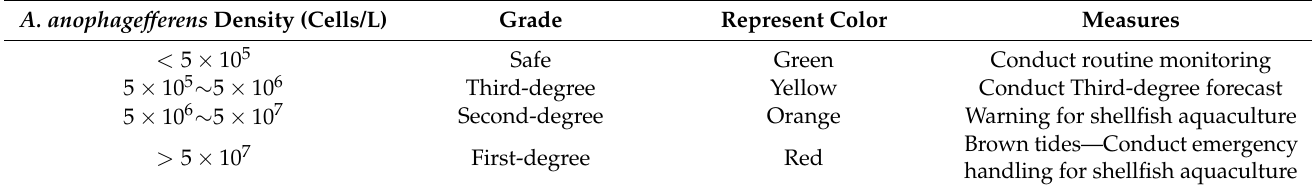
Table 5. The brown tide warning and fast forecast monitoring indicator of A. anophagefferens density.